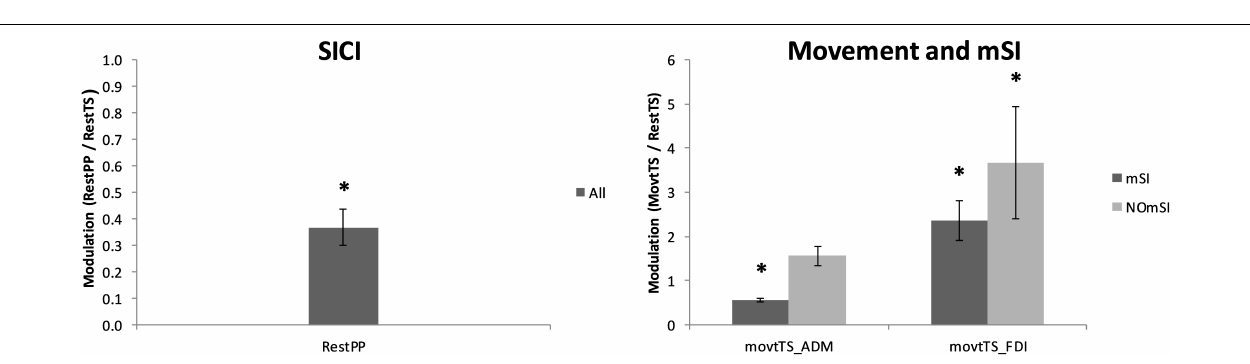
FIGURE 3 | Averaged MEPs across conditions. Left: ADM MEP amplitude suppression by SICI (RestPP) is displayed as a ratio of 1 (RestTS). Right: ADM and FDI MEP amplitude modulation by movement onset (MovtTS) in subjects with and without motor surround inhibition (mSI) (mean ± SE; ∗ P <